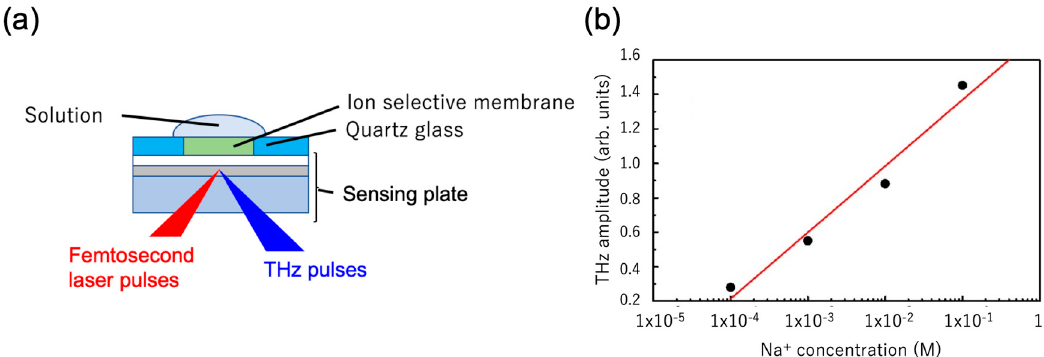
Figure 7. ( a ) Cross-sectional schematic of the sensing plate with an ion-selective membrane on the surface. The solution containing sodium ions was dropped onto the membrane. ( b ) THz pulse amplitude versus sodium-ion concentration in the solution during femtosecond laser illumination beneath the ion-selective membrane. The red line is the linear best fit to the data.